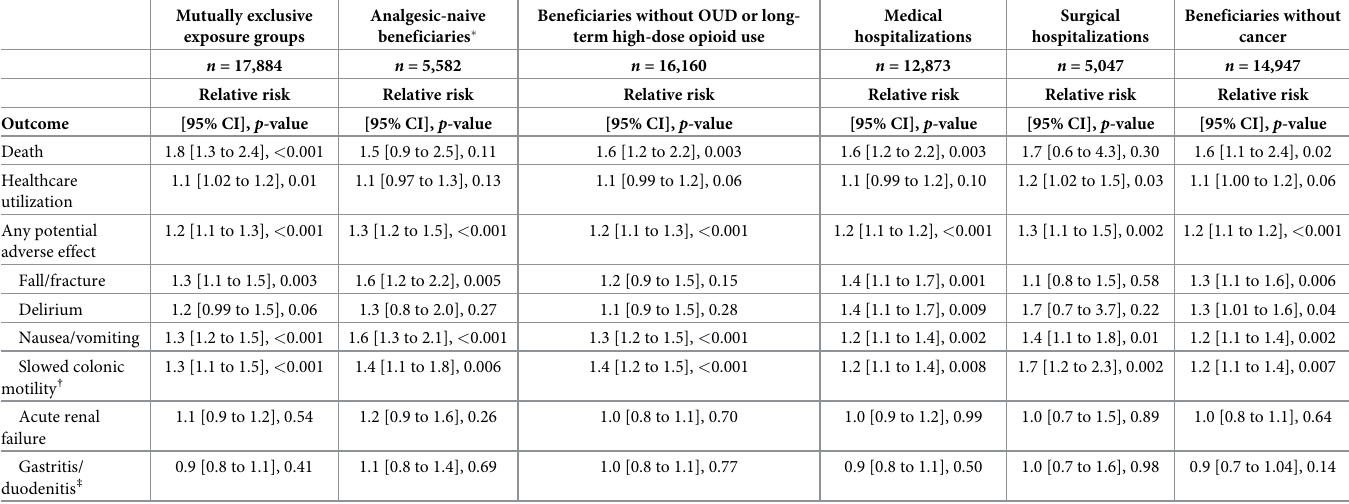
Table 4. Relative risk for opioids compared to NSAIDs in the propensity-matched cohorts of prespecified subgroups. Mutually exclusive Analgesic-naive Beneficiaries without OUD or long- exposure groups beneficiaries � term high-dose opioid